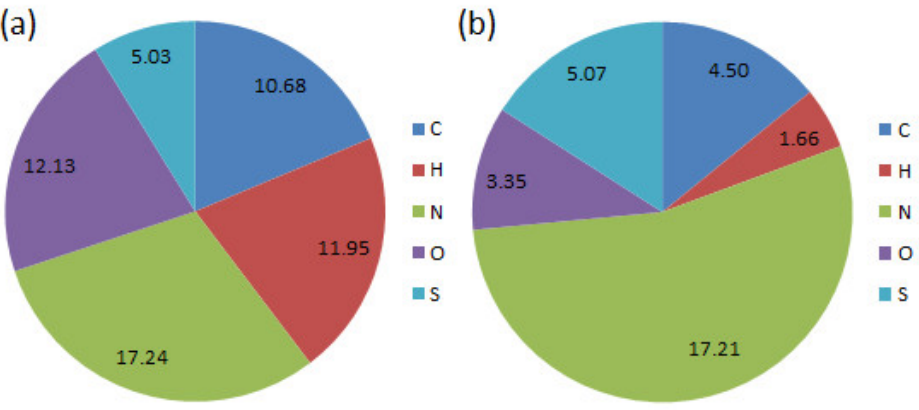
Figure 19. Percentage of atom losses; ( a ) the first experiment, ( b ) the second experiment.